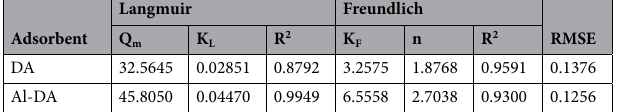
Langmuir Freundlich Adsorbent RMSEQ